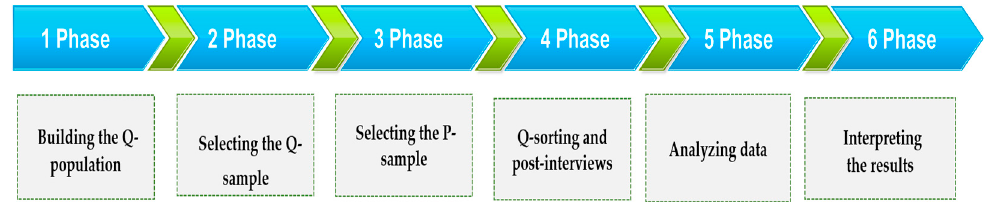
Figure 1. Research process and procedure.